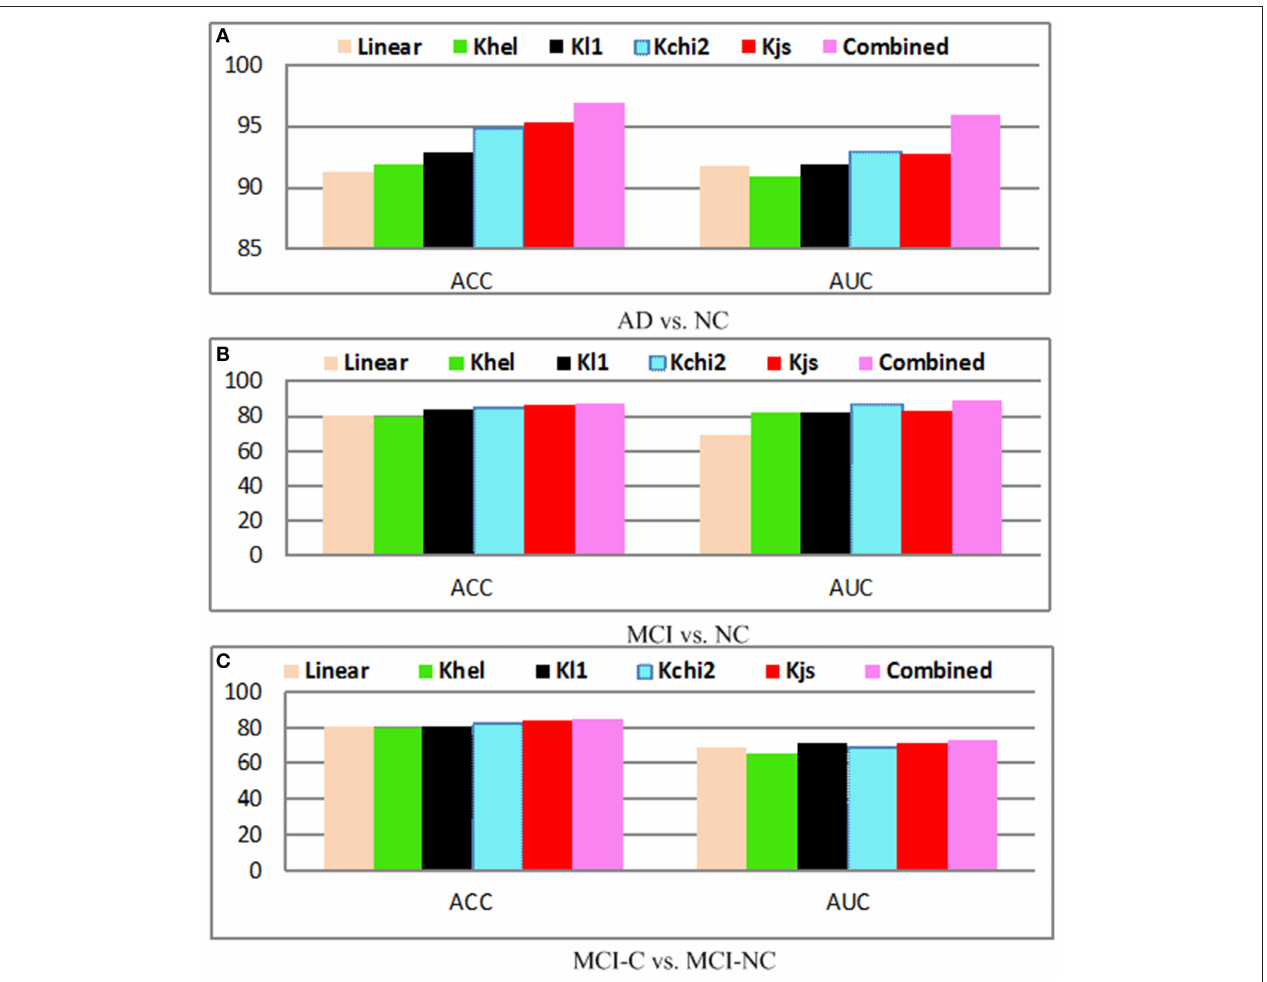
FIGURE 10 | Diagnosis results with different kernels; (A) AD vs. NC; (B) MCI vs. NC; (C) MCI-C vs.